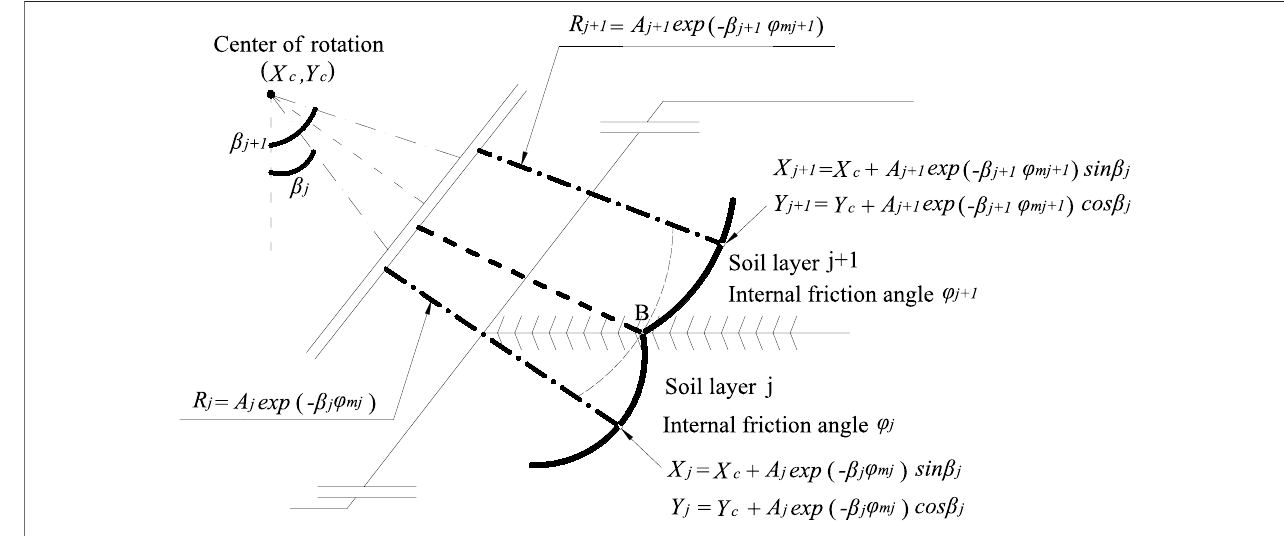
FIGURE 3 | Calculation diagram of shape of the logarithmic spiral slip surface of the multi-layer slope.